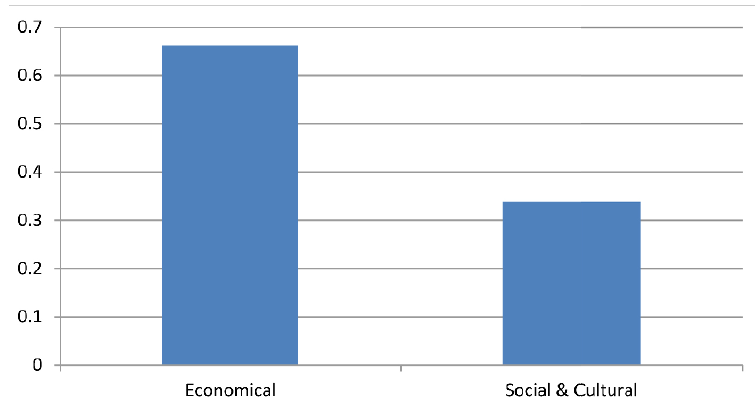
Figure 4: The priority of costs indices in first level (inconsistency rate 0.00), X: Criteria, Y: Weighing